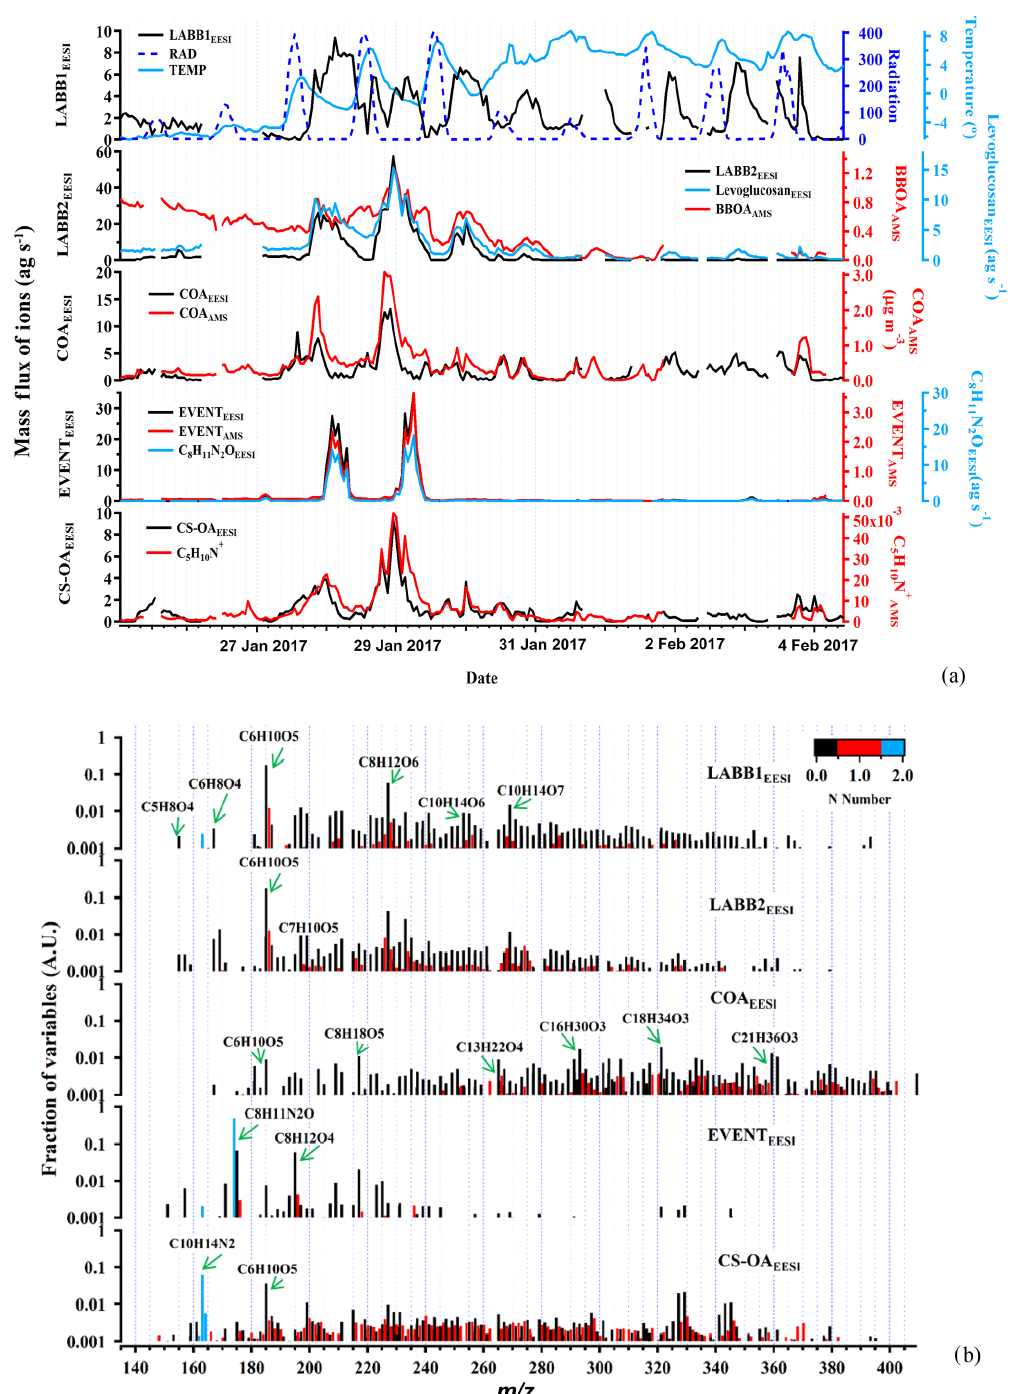
Figure 2. Time series of the POA factors retrieved from EESI-TOF-MS PMF analysis, along with ancillary data (a) , and corresponding factor profiles (b) . For all y axes, EESI-TOF-MS data are shown in mass flux (ags − 1 ), AMS data are shown in micrograms per cubic meter, and other units are given. Factor profiles are molecular weighted and are normalized such that the sum of each profile is 1.